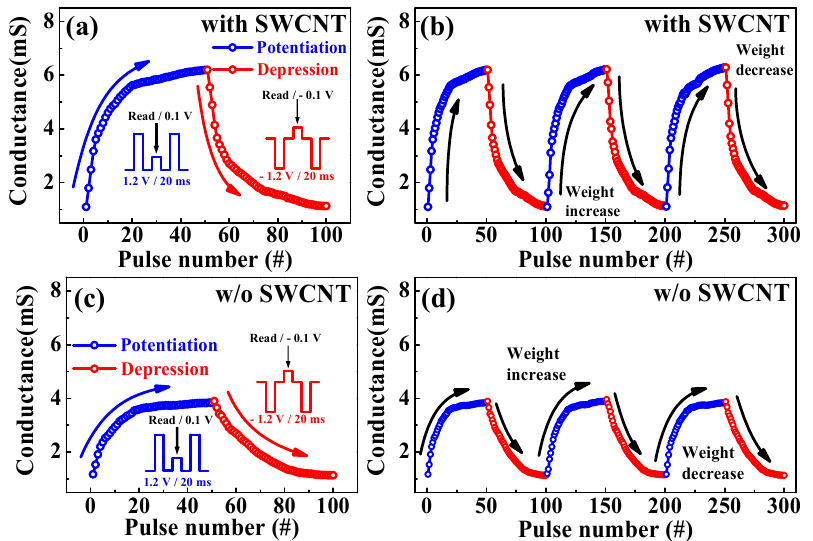
Figure 9. Potentiation and depression behavior of chitosan nanocomposite memristors ( a ) with and ( c ) without SWCNT random networks. Cycle testing under stimulation from 300 synaptic pulses for memristors ( b ) with and ( d ) without SWCNT random networks.